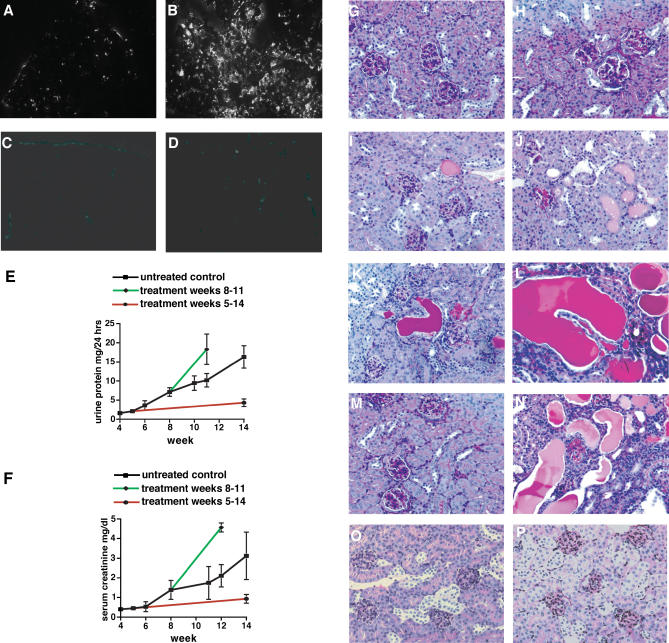
Effect of Combined MMP-Inhibition on the Progression of Renal Disease in
α3(IV)
−/− Mice
(A–D) In situ zymography. In situ zymography displayed gelatin-degrading activity in normal kidneys (A), which was substantially increased in kidneys of 14-wk-old
COL4A3
−/− mice (B). Incubation with the MMP-2, MMP-3, or MMP-9–inhibitor cocktail significantly blocked MMP activities in kidneys from wild-type mice (C) and kidneys from
COL4A3
−/− mice (D).
(E and F) Renal function in
α3(IV)
−/− mice. Urinary protein excretion (E) was measured in urine, which was collected over a 24-h period in metabolic cages. Serum creatinine (F) was determined in serum samples that were obtained bi-weekly from mice. The graphs display the progression of urinary protein excretion and serum creatinine levels from 4 to 14 wk of age. In each panel, disease progression is shown in untreated control mice (black), in mice that received MMP-inhibitors starting at 5 wk of age (red), and in mice that received MMP-inhibitors starting at 8 wk of age (green).
(G–N) Kidney histology from
α3(IV)
−/− mice. The images display representative periodic acid-Schiff (PAS)–stained kidney sections from
α3(IV)
−/− mice, together with images displaying representative kidneys from untreated α
3(IV)
−/− mice to illustrate disease progression (G–L). At the age of 3 wk, the kidneys appear completely normal (G). At 4 wk of age, a few glomeruli appear hypercellular, representative of inflammatory cells (H). At the age of 6 wk, a few tubules filled with protein casts appear (I). At 8 wk of age, a few sclerotic glomeruli are present, and atrophic tubules containing protein casts become more abundant (J). At the age of 10 wk, increased numbers of mononuclear cells associated with widening of the interstitial space indicate the onset of interstitial fibrosis (K). At 14 wk of age, the kidneys display severe tubular atrophy, glomerulosclerosis, and interstitial fibrosis, reflecting ESRD (L). A kidney section is displayed of a 14-wk-old
α3(IV)
−/− mouse that received MMP-inhibitors from 4 wk of age (M). Initiation of treatment after week 4 (compare with H) led to substantially ameliorated disease after 14 wk (M, compare with L). A representative kidney section of a
α3(IV)
−/− mice at week 11 that received MMP-2–inhibitors, MMP-9–inhibitors, and MMP-3–inhibitors, starting at week 8 and displaying enhanced progression of disease, is displayed (N, compare with K). (Original magnification of PAS-stained histologies: ×200).
(O and P) Representative kidney sections from wild-type control mice at 4 wk of age (O) and 14 wk of age (P) are displayed. (Original magnification of PAS-stained histologies: ×200).